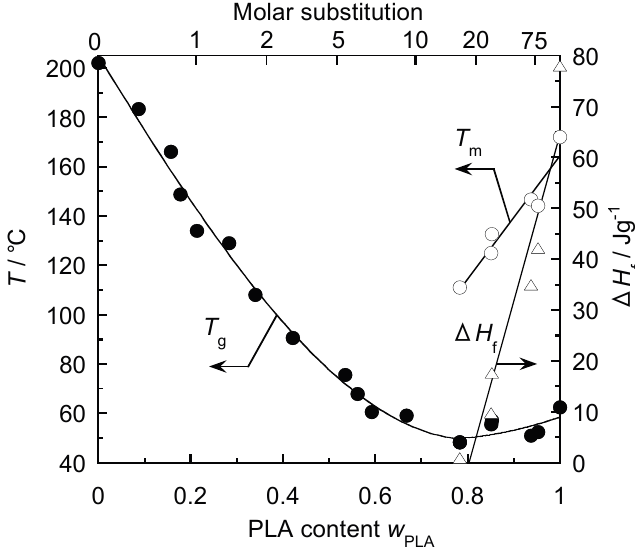
Figure 19. Composition dependence of the thermal transition parameters T g , T m , and Δ H f , estimated by DSC for CA 2.15 - g -PLA samples. T m and Δ H f were obtained in the first run while T g was evaluated in the second heating scan. Reproduced with permission from ref. [55]. Copyright 2003 Elsevier Science